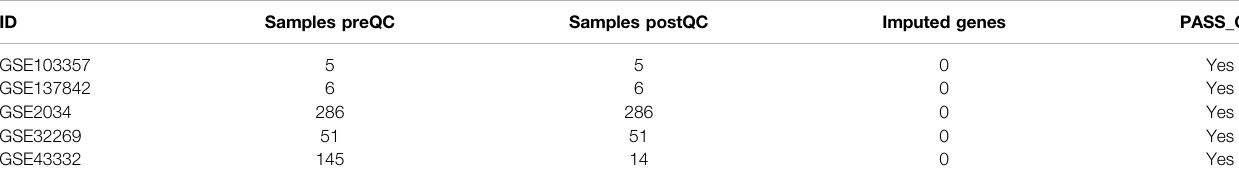
TABLE 3 | The dataset quality control results generated by the ImaGEO tool.